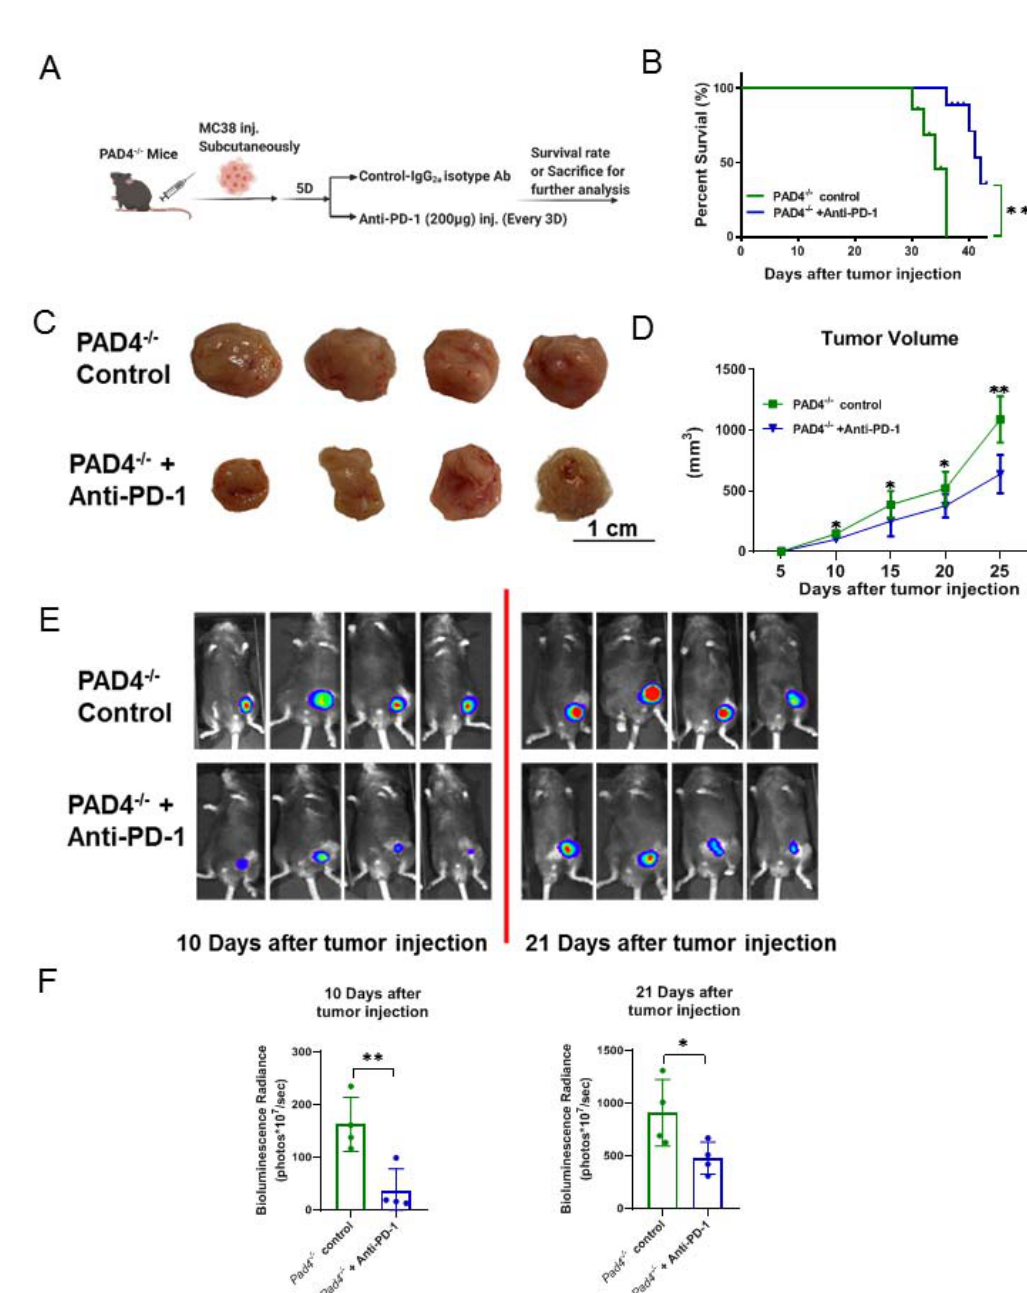
Figure 5. Being genetically incapable of NET formation improves the efficacy of PD-1 blockade to reduce the growth of cancer. ( A ) Experiment outline. PAD4 − / − male mice received MC38 colorectal cancer cell injections and the mice were treated with IgG2a isotype control or anti-PD-1. ( B ) The percentage of overall survival; n = 10 mice/group. ( C ) Representative photograph of flank tumor with different treatments at day 21 after tumor injection. Scale bar = 1 cm; n = 6 mice/group. ( D ) Tumor growth curves were established by measuring flank tumors lengthwise and widthwise using the formula (d2 × D)/2 to calculate tumor volume every 2–3 days starting at day 5; n = 6 mice/group. ( E , F ) The use of luciferase-labeled MC38 cells allowed in vivo tracking of tumor growth with bioluminescence imaging at day 10 and day 21; n = 6 mice/group. Survival curves were analyzed by log-rank (Mantel–Cox) test ( B ). The graphs show the ± SD. ANOVA with adjustment for multiple comparisons for ( B , D ). Unpaired two-sample Student’s t test for ( F ). Note: * p < 0.05, ** p < 0.01, *** p < 0.001; NS: not significant. All statistical tests used in this figure were two-sided and p < 0.05 was considered statistically significant.